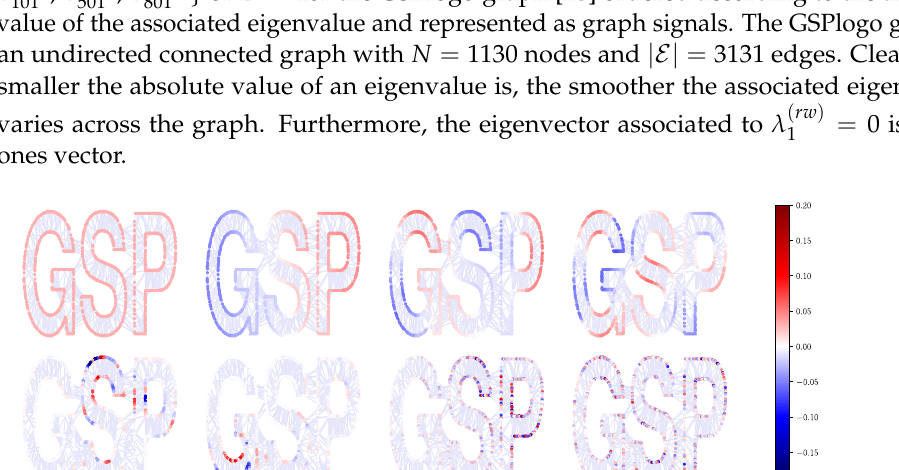
Figure 4. Eigenvectors of L ( rw ) for the GSPlogo graph corresponding to eigenvalues λ ( rw ) ( rw ) ( rw ) ( rw ) ( rw ) λ , λ , λ , λ , λ , and λ 6 11 51 101 501